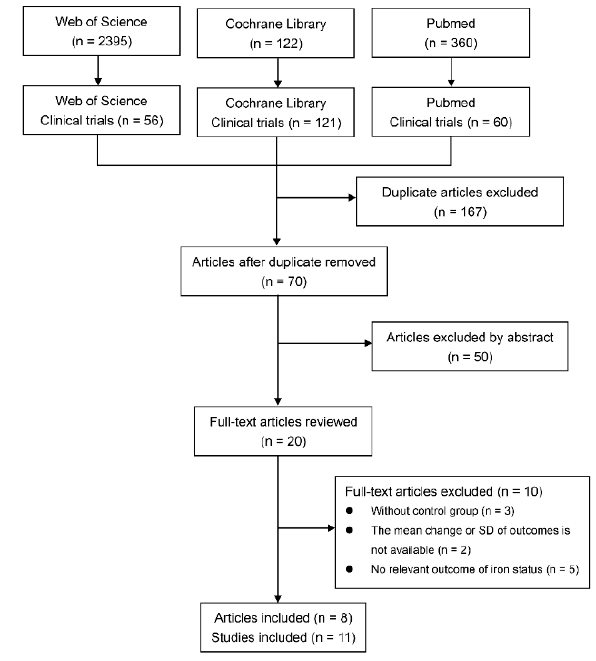
Figure 1. Study identification and selection flow diagram.